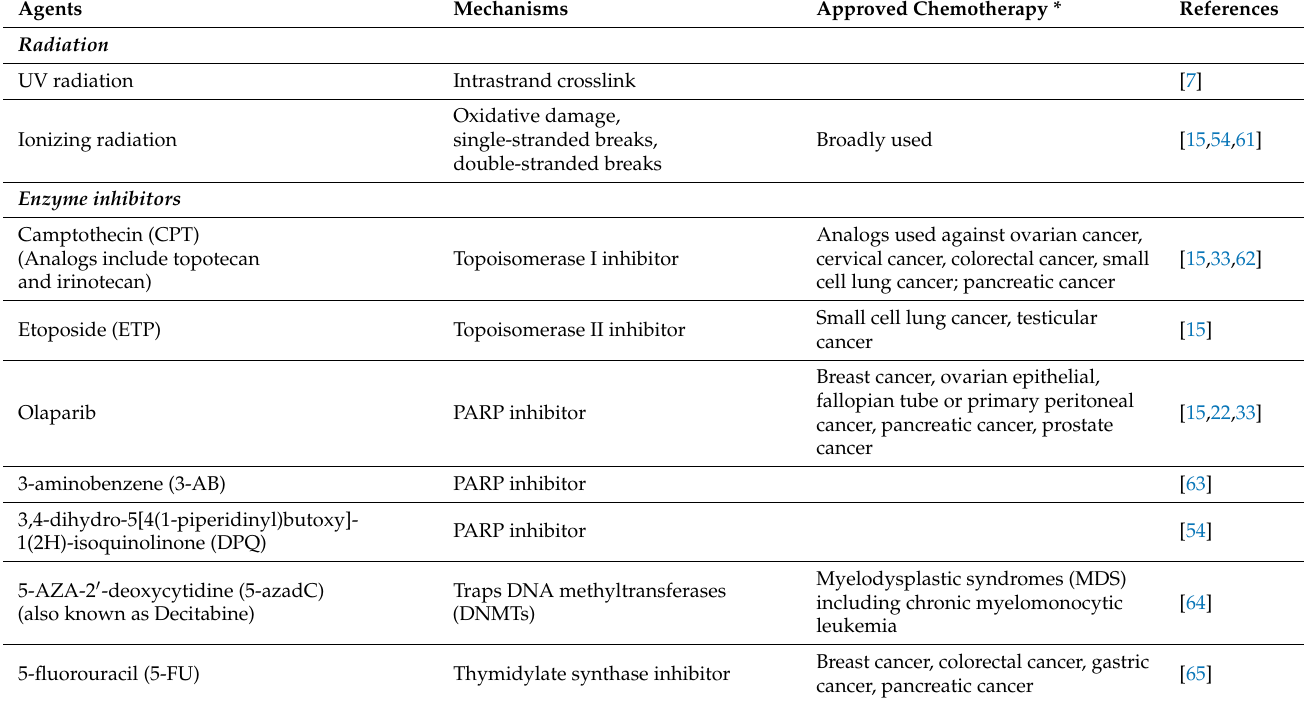
Table 2. List of a variety of DNA damage-inducing agents to which CSB-deficient cells are